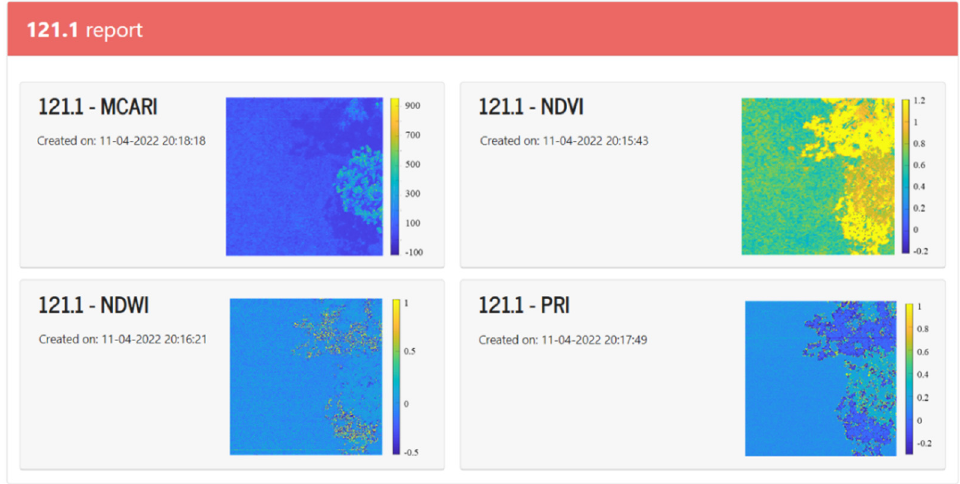
Figure 14. Snapshot of (MCARI, NDVI, NDWI, and PRI) indexes visualization.